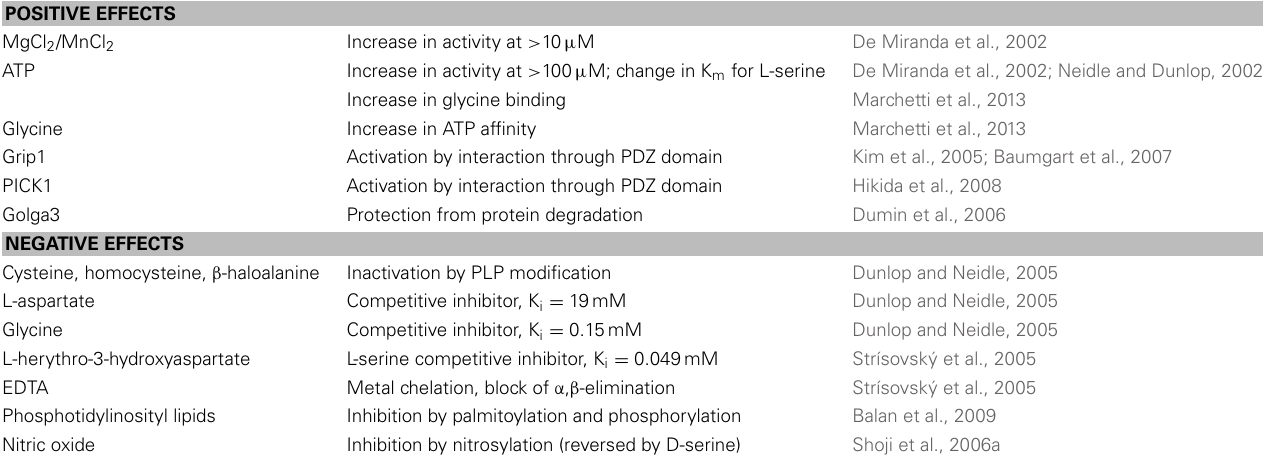
Table 1 | Known modulators of SR (activity and